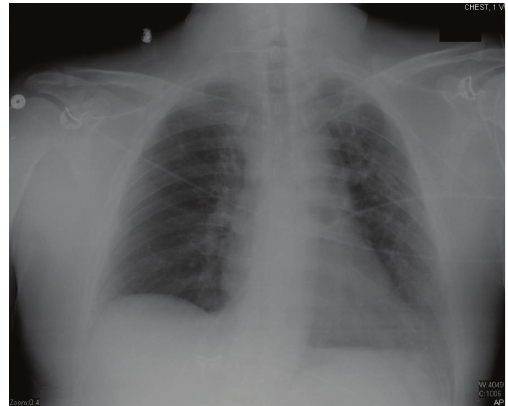
Figure 2: Chest X-ray day 18 after chemotherapy (ANC was 1100 cell/ µ L).